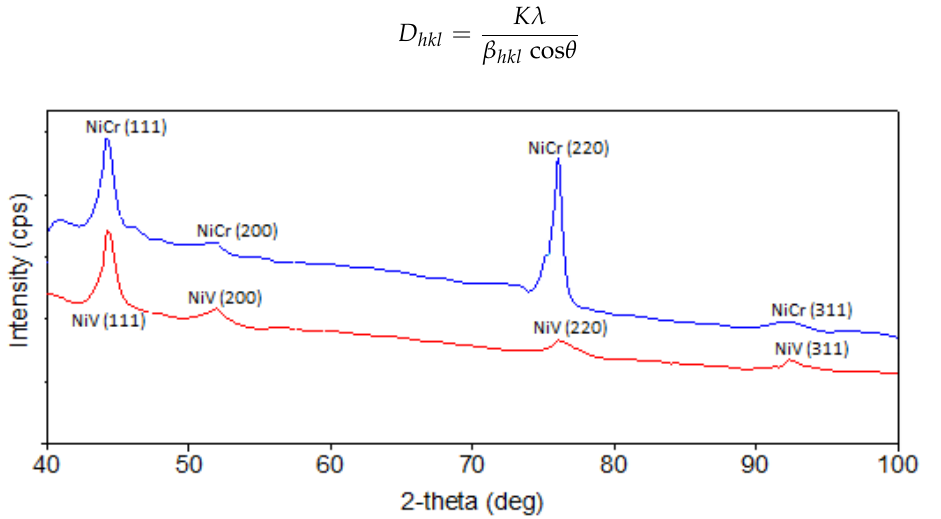
Figure 3. XRD patterns of thin-film catalysts. The blue line is the XRD curve of the NiCr catalyst, and the red line is the XRD curve of the NiV catalyst.